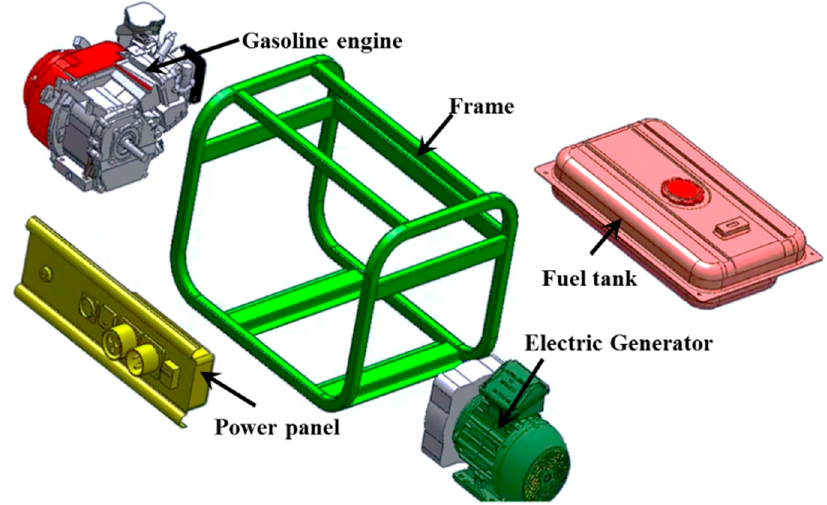
Figure 1. Dissembled view of portable generator.